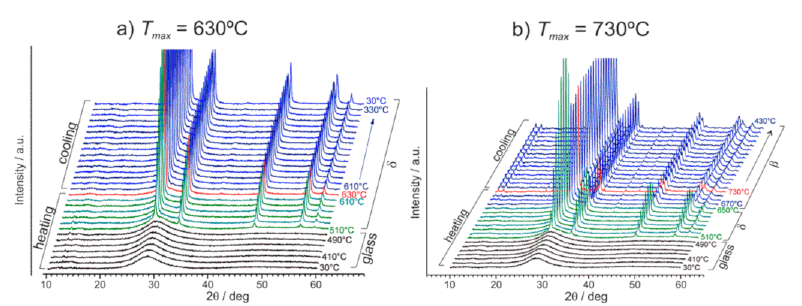
Figure 14. XRD patterns of initially amorphous Bi 2 O 3 samples at series of temperatures on heating and cooling stages up to: ( a ) 630 ◦ C and ( b ) 730 ◦ C. Temperature intervals are 20 ◦ C on both heating and cooling ramps. (Reproduced with permission from ref. [79]. Copyright 2018, Elsevier).